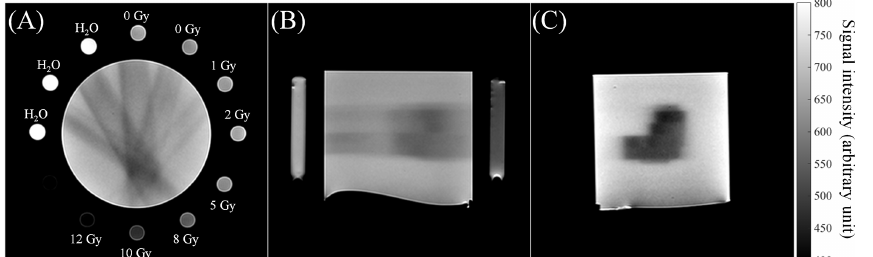
Figure 6. Examples of T2-weighted images of the irradiated NIPAM gel phantom: ( A ) Axial, ( B ) sagittal and ( C ) coronal images. The calibration tubes filled with NIPAM gel exposed to given doses (reported in Figure A ) are located around the centran phantom. Reproduced from